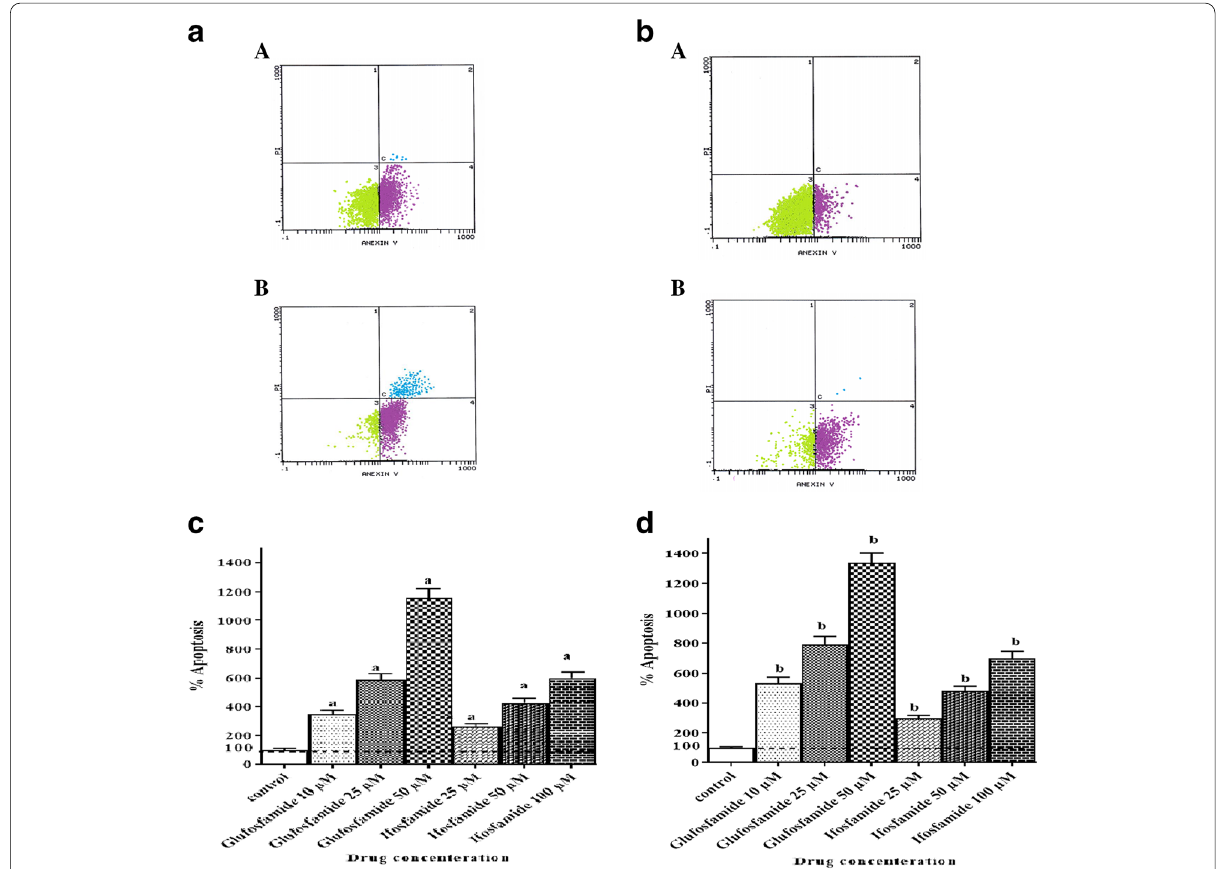
Fig. 2 Effects of glufosfamide or ifosfamide on the frequency of apoptosis following Annexin V FITC/Pl double stain. a ANNEXIN V FITC/Pl apoptosis assay for HepG2 cells after glufosfamide IC 50 (50 µM) treatment for A 48 h and B 72 h. b ANNEXIN V FITC/Pl apoptosis assay for HepG2 cells after ifosfamide IC50 (100 µM) treatment for A 48 h and B 72 h. c Comparative effects of glufosfamide or ifosfamide on the frequency of apoptosis